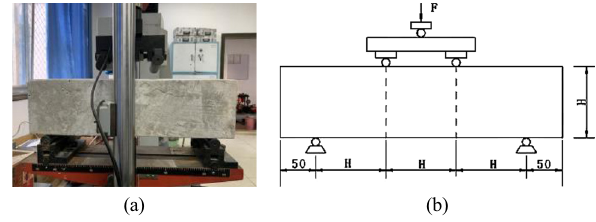
Figure 6: Four - point bending strength test equipment: ( a ) loading device and ( b ) schematic loading diagram.